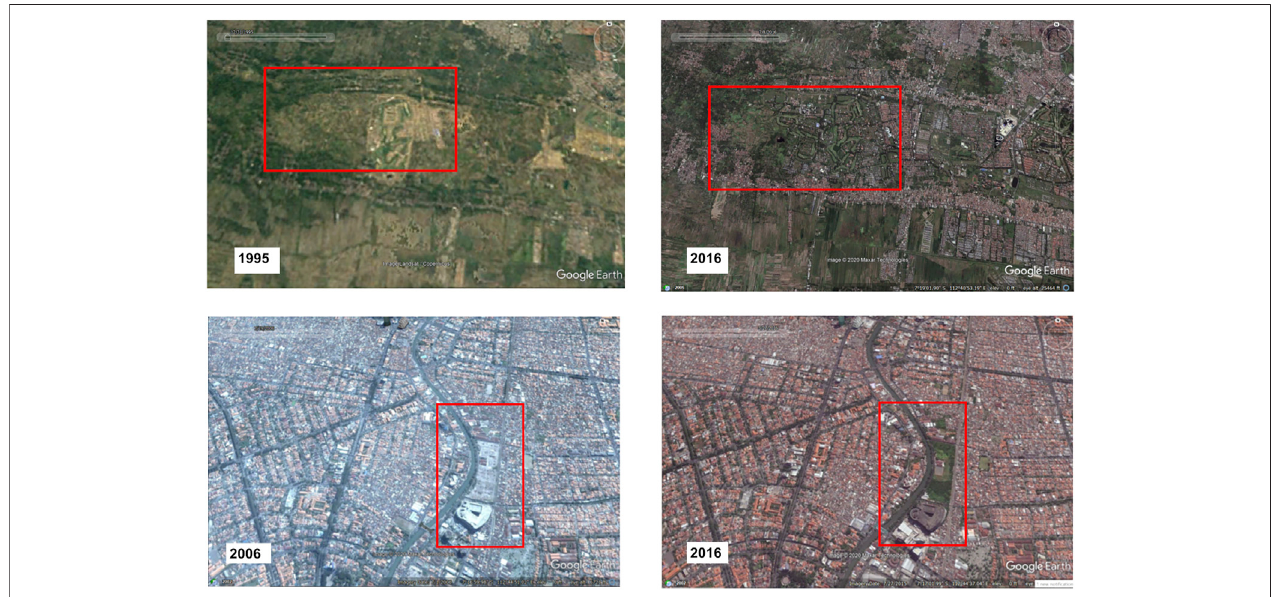
FIGURE 2 | Land-cover changes in Surabaya city that can be observed in the historical imagery of Google Earth